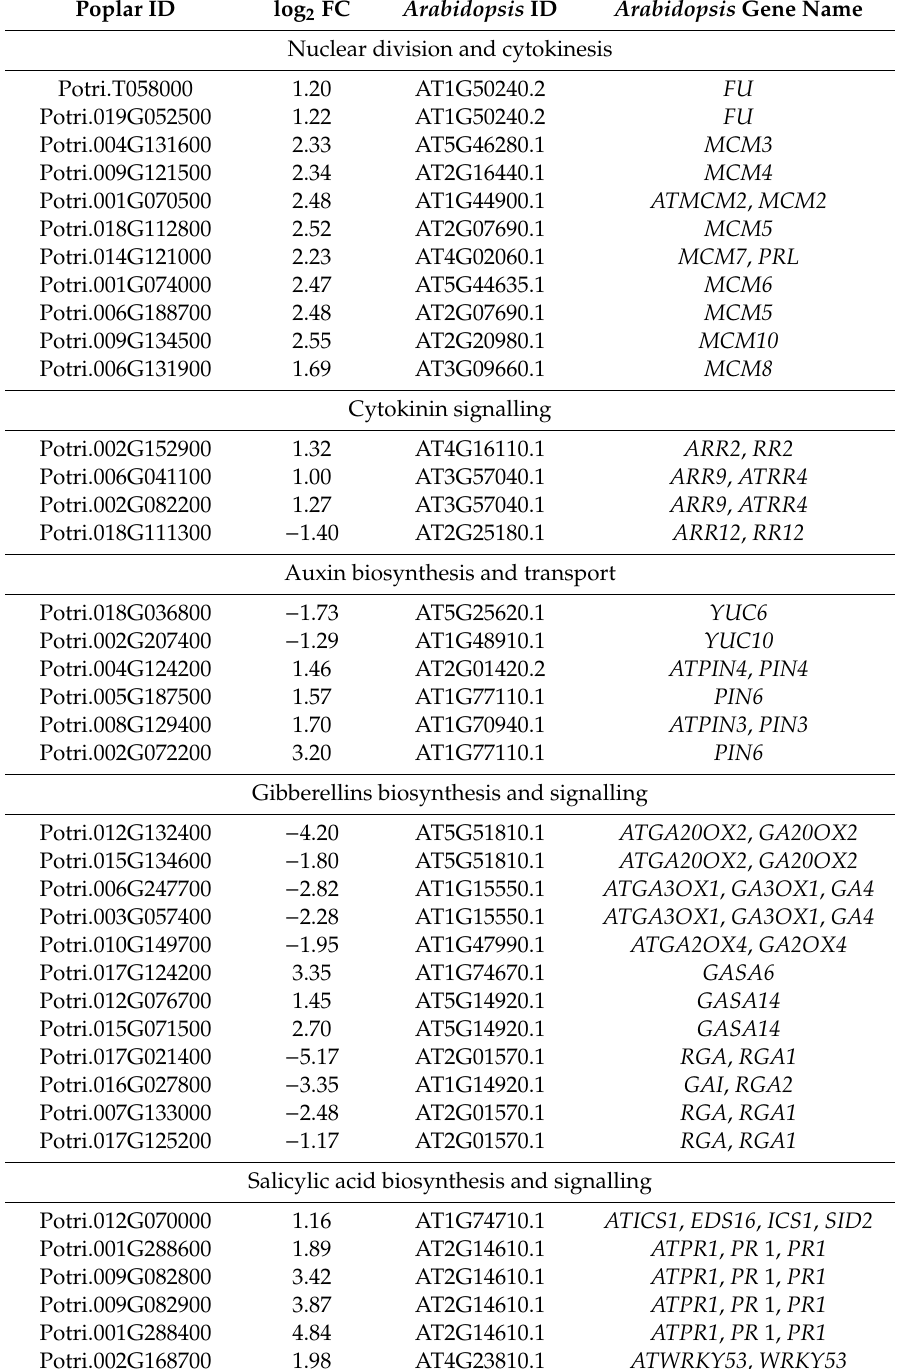
Table 4. Di ff erentially expressed genes involved in phytohormones biosynthesis, signalling and transport in 21 dai galls versus uninfected